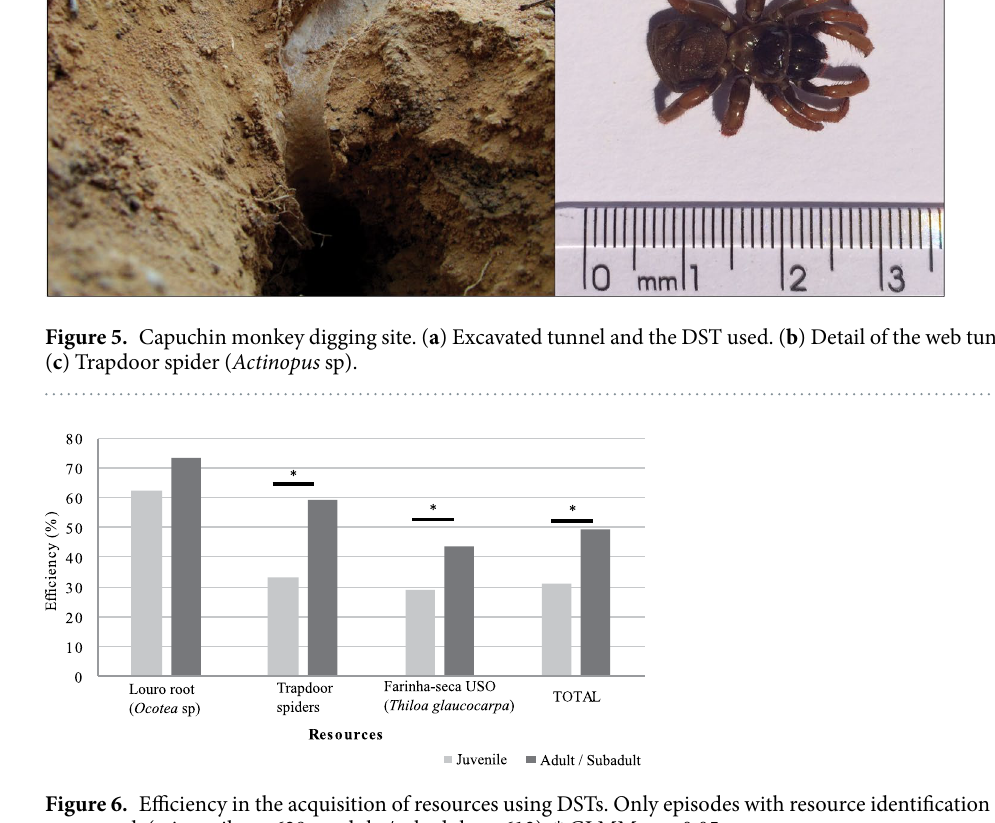
Figure 6. Efficiency in the acquisition of resources using DSTs. Only episodes with resource identification are accounted. (n juveniles = 628; n adults/subadults = 613). * GLMM, p <